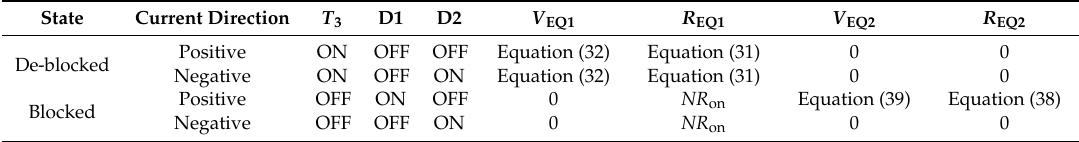
Figure 8. The Thévenin equivalent circuit for full states: ( a ) Thévenin equivalent circuit; ( b ) Steady state; ( c ) Positive current at blocked state; ( d ) Negative current at blocked state. Table 1. The parameters of the equivalent